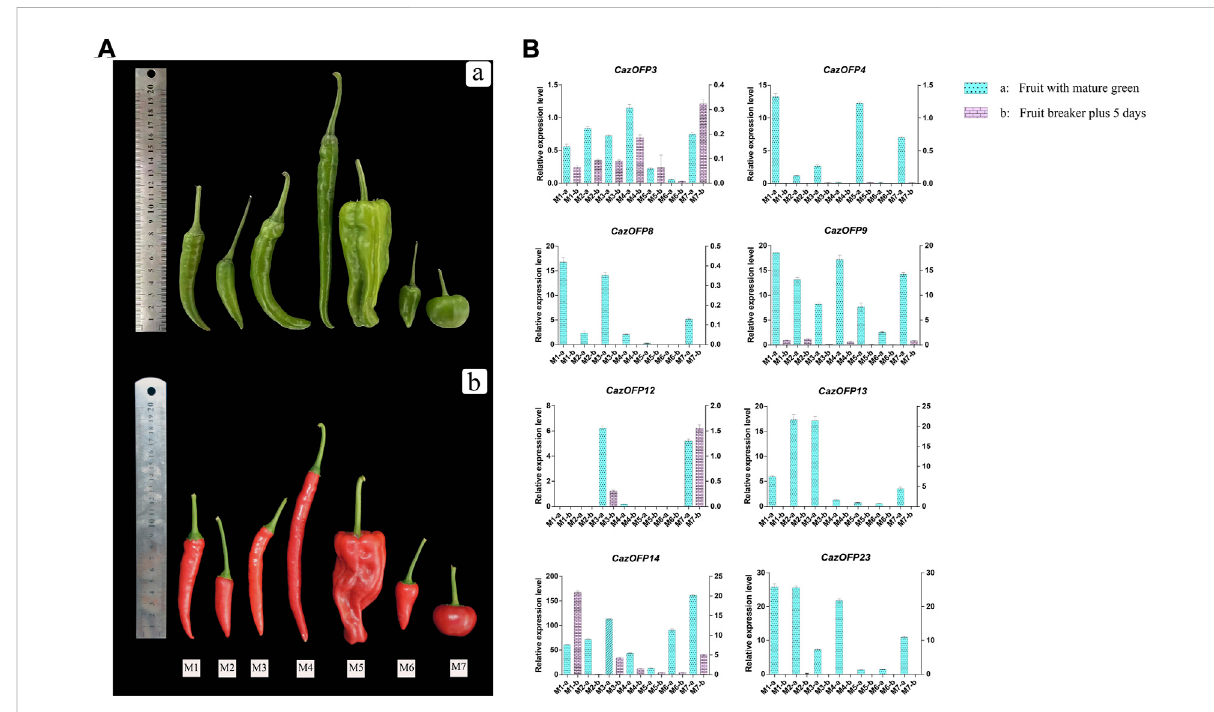
FIGURE 8 Expression of eight CazOFP genes in two developmental stages of seven pepper varieties with different fruit shapes. (A) Fruit diagrams of seven varieties with different fruit shapes. These varieties (M1-M7) are zunla-1, ZJ-5, 11C255-1, ZJ11, HYL, ZJ-1 and T803. Above is the fruit development stage 1 (fruit with mature green), Below is the fruit development stage 2 (fruit at breaker plus 5 days). (B) The levels of these eight CazOFP genes detected by